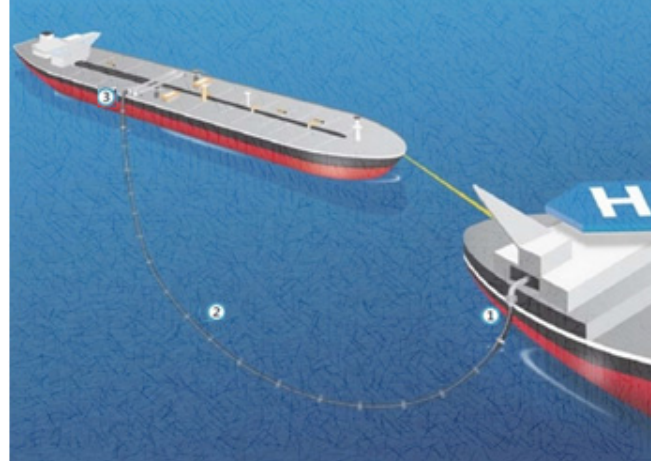
Figure 17. Tandem mooring submarine hose configuration. Table 4. Arrangement of tandem mooring submarine and catenary hoses.